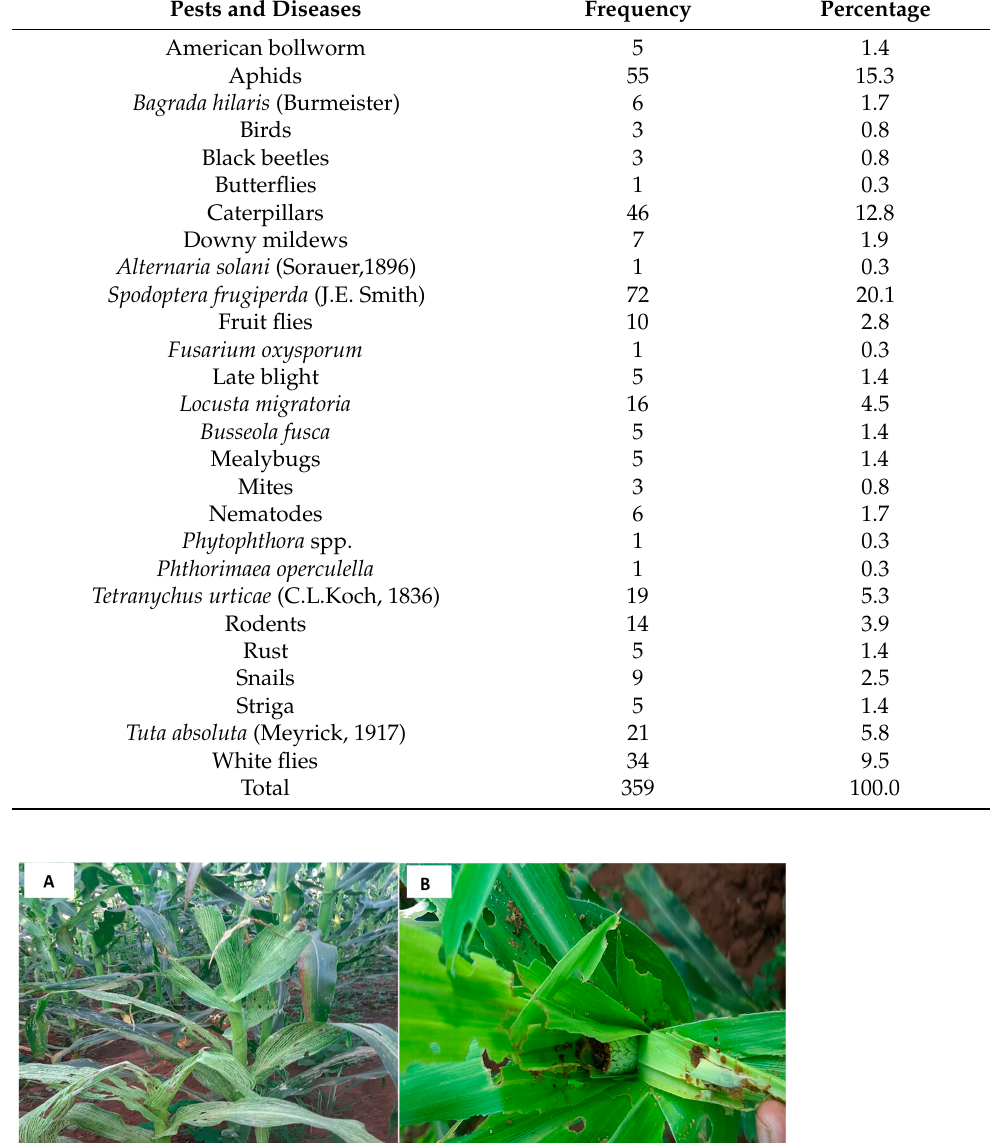
Table 7. List of problematic pests and diseases detected in the Vhembe district.